Question: Briefly state, in one sentence, what is plotted here.
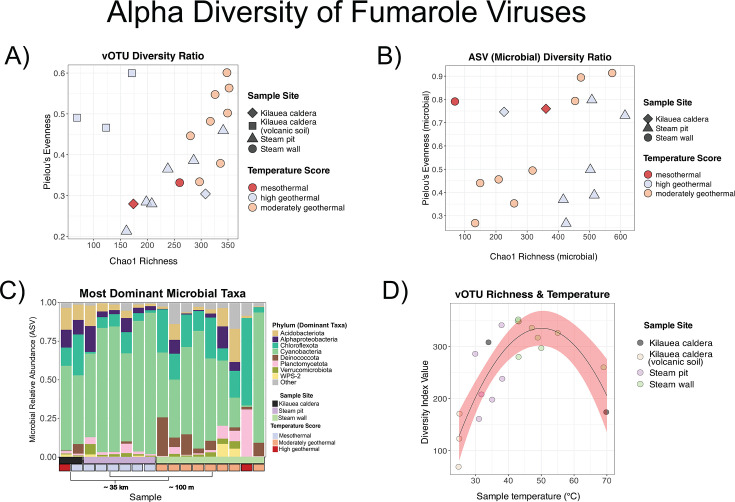
Answer: ( A ) Richness (Chao1) and evenness (Pielou) of fumarole vOTUs calculated from RPKM-based relative abundances ( Table S6 ). Each point represents a sample. Shape indicates sample site, and color indicates temperature at the time of collection. ( B ) Richness and evenness of microbial ASV relative abundances. Each point represents a sample; color and shape denote sample characteristics as described in panel A . ( C ) Relative abundance of the most abundant bacterial taxa across samples based on ASVs. The top five phyla per sample are shown and used for visualization. The second row indicates sample site, and the bottom row indicates temperature at collection. The phylogram shows spatial relationships among sites: the steam pit and steam wall are ~100 m apart, while the Kīlauea caldera cave is ~35 km from both. ( D ) Sample temperature versus vOTU richness (Chao1). Each point represents a sample, colored by site. vOTU richness follows a temperature-dependent pattern modeled by a polynomial (quadratic) regression. Richness increases with temperature up to ~50°C and declines thereafter.